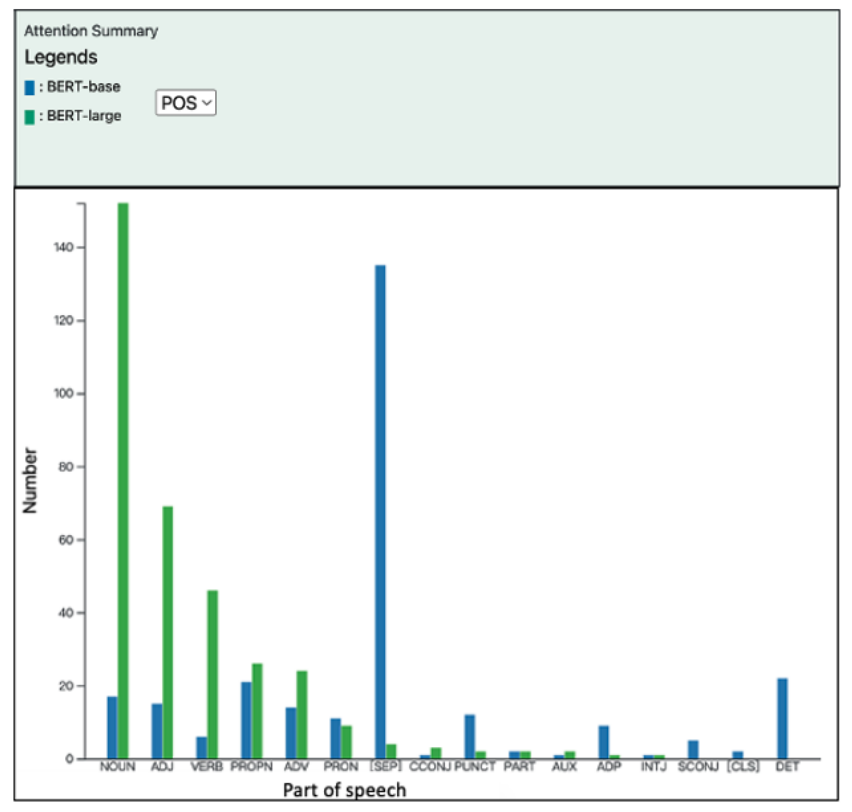
Figure 26. The five longest bars of the bert-large model are NOUN, ADJ, VERB, PRON and